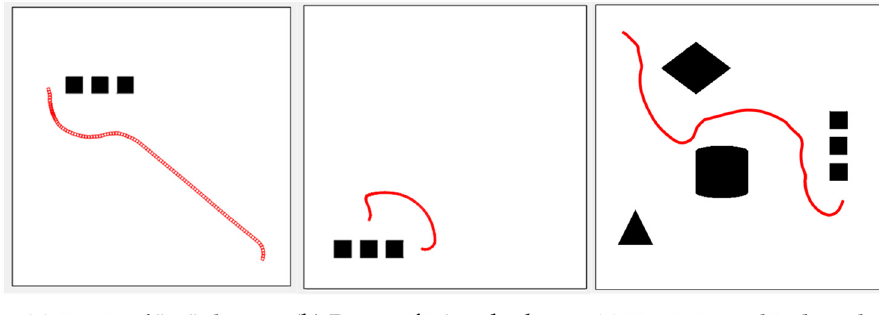
Figure 19. Modular vehicle path in reconfiguration.